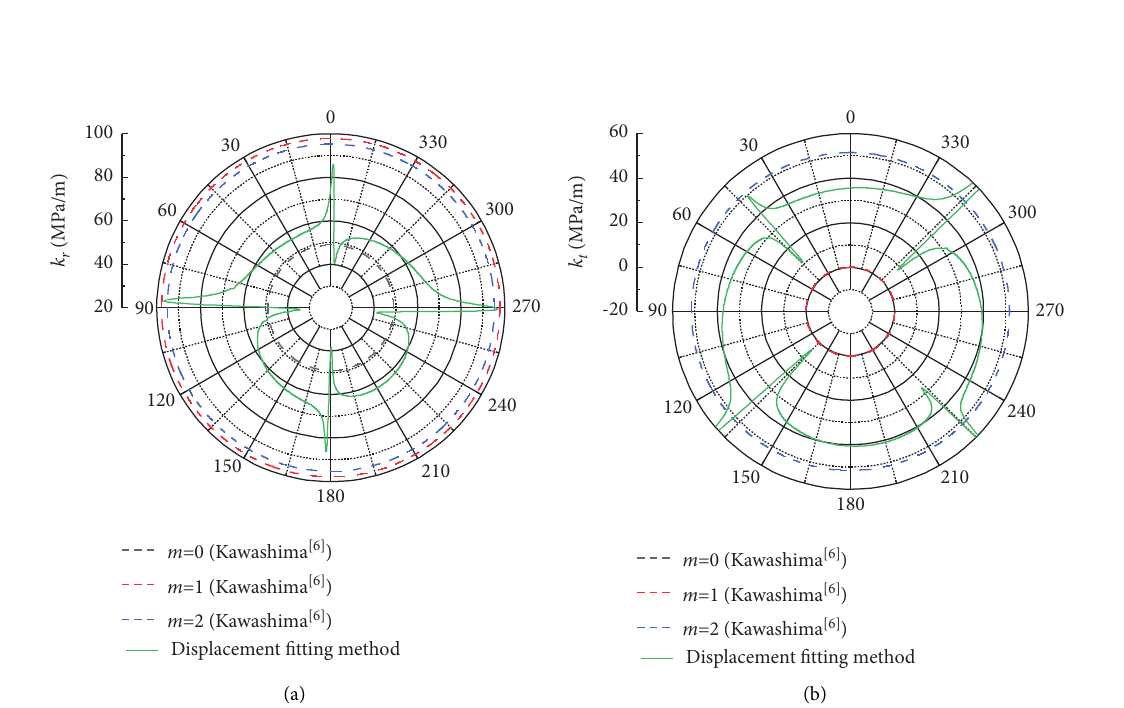
Figure 11: Subgrade modulus. (a) Radial subgrade modulus; (b) tangential subgrade modulus.